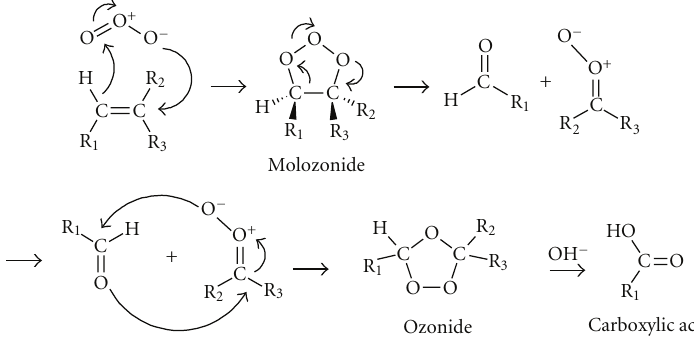
Figure 2: Chemical reaction of carbon-carbon double bond with wet ozone.